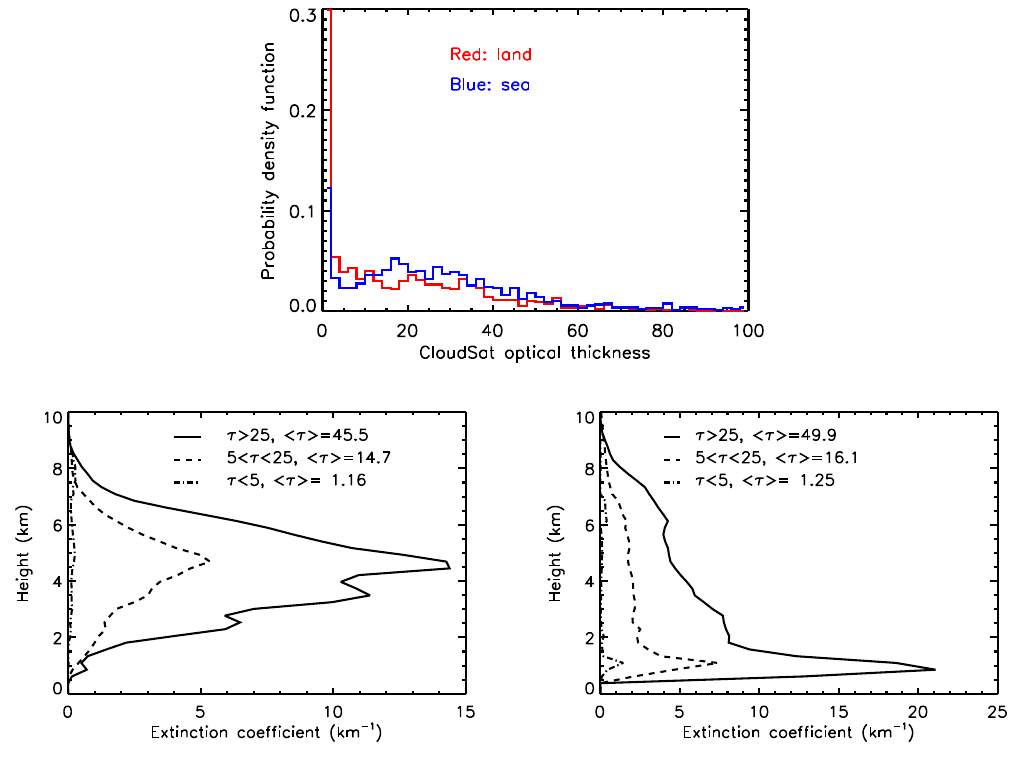
Fig. 4. Top: probability density function of cloud optical thickness for cloudy data over Antarctica and surrounding sea ice on 13 November 2006. Bottom: average profiles of cloud extinction for three τ bins and latitudes < − 60 ◦ . Left: land; right: sea.